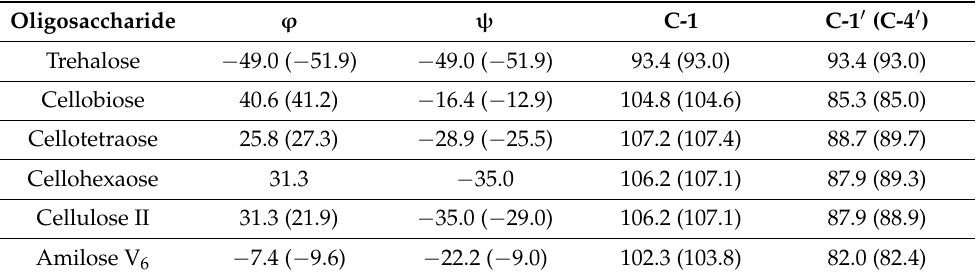
Table 7. Calculated and experimental (in parenthesis) 13 C-NMR chemical shifts of different oligosac- charides in solid state. Compiled from Sergeyev and Moyna